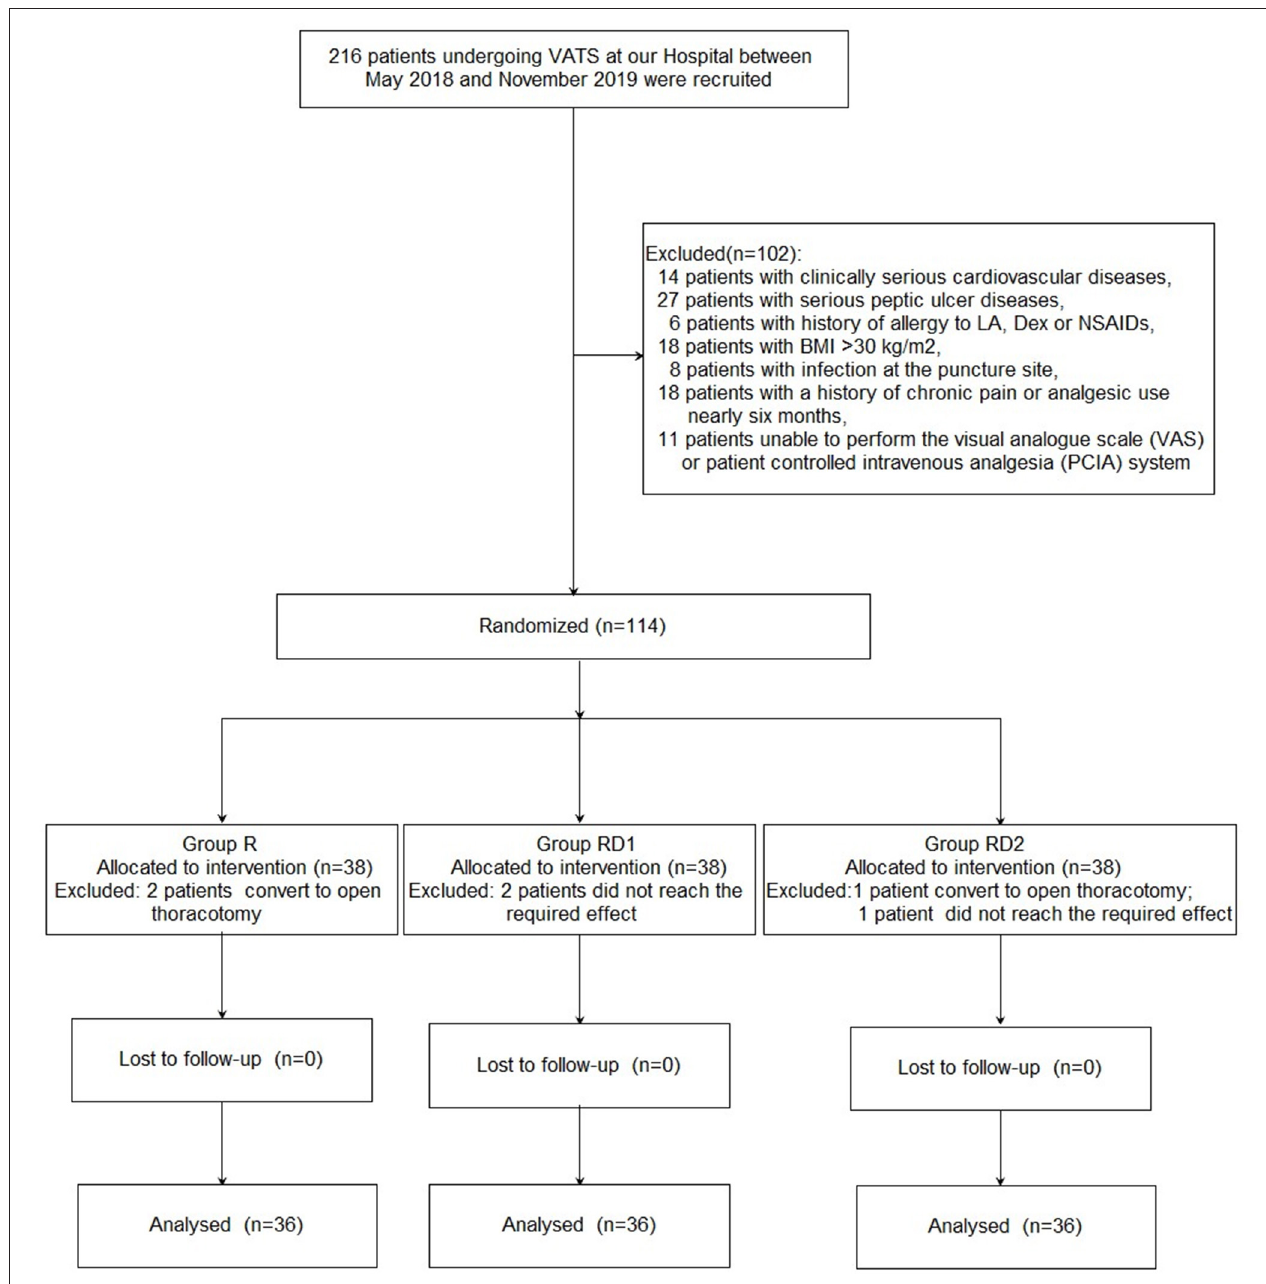
FIGURE 1 | Patient consort flow